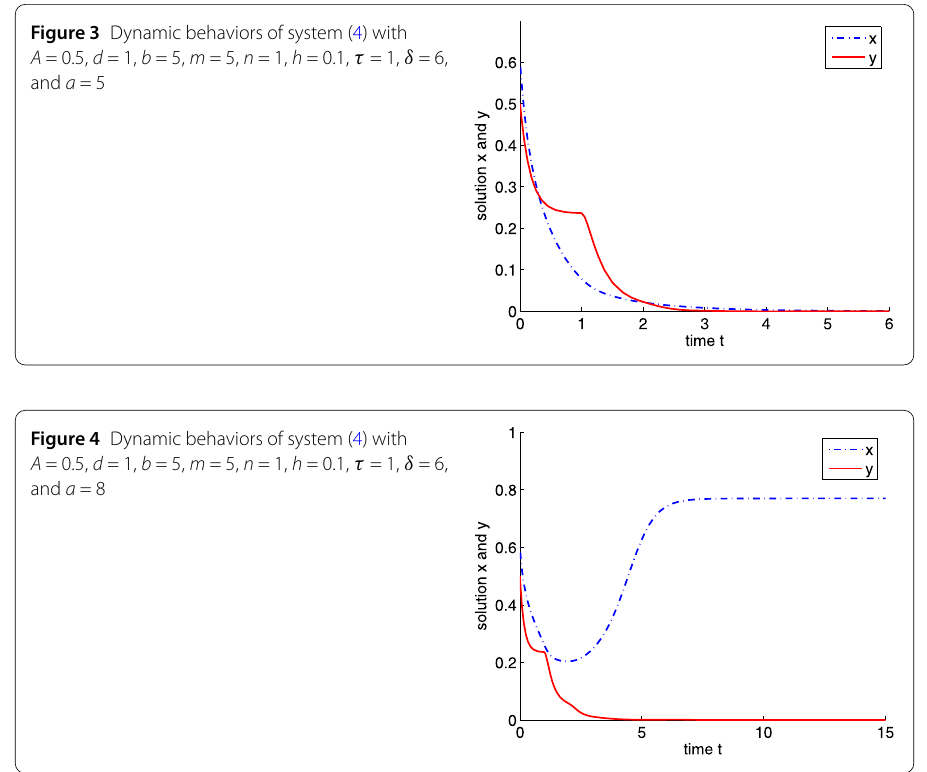
Figure 3 Dynamic behaviors of system (4) with A = 0.5, d = 1, b = 5, m = 5, n = 1, h = 0.1, τ = 1, δ = 6, and a = 5